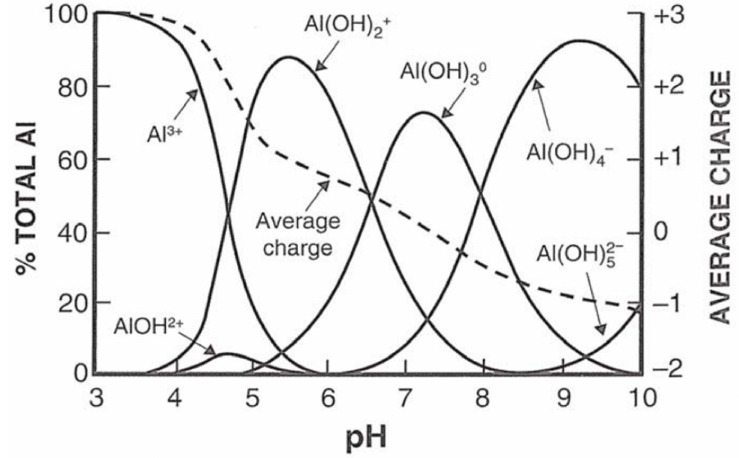
Figure 1. Relationship between pH and the distribution of soluble aluminium species